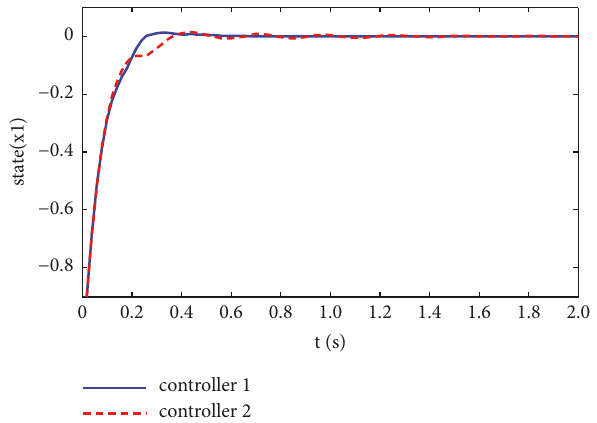
Figure 10: Trajectory of state 𝑥 1 with two controllers on condition 𝜏 = 3,𝜌 = 3 .